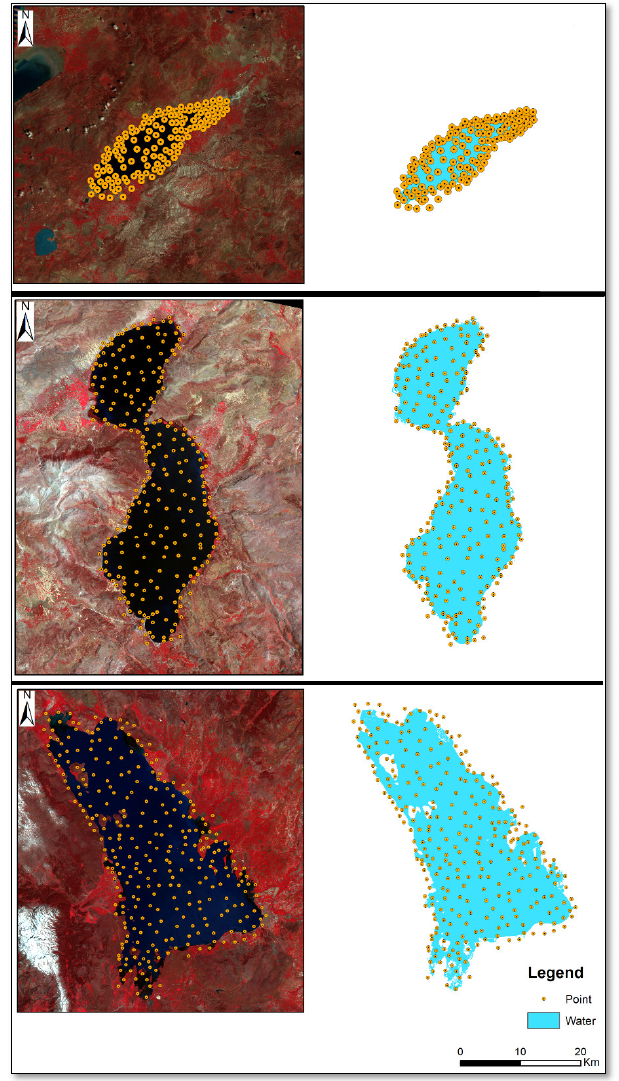
Figure 4. Illustration of the random points used for the accuracy assessment of lake surface area.